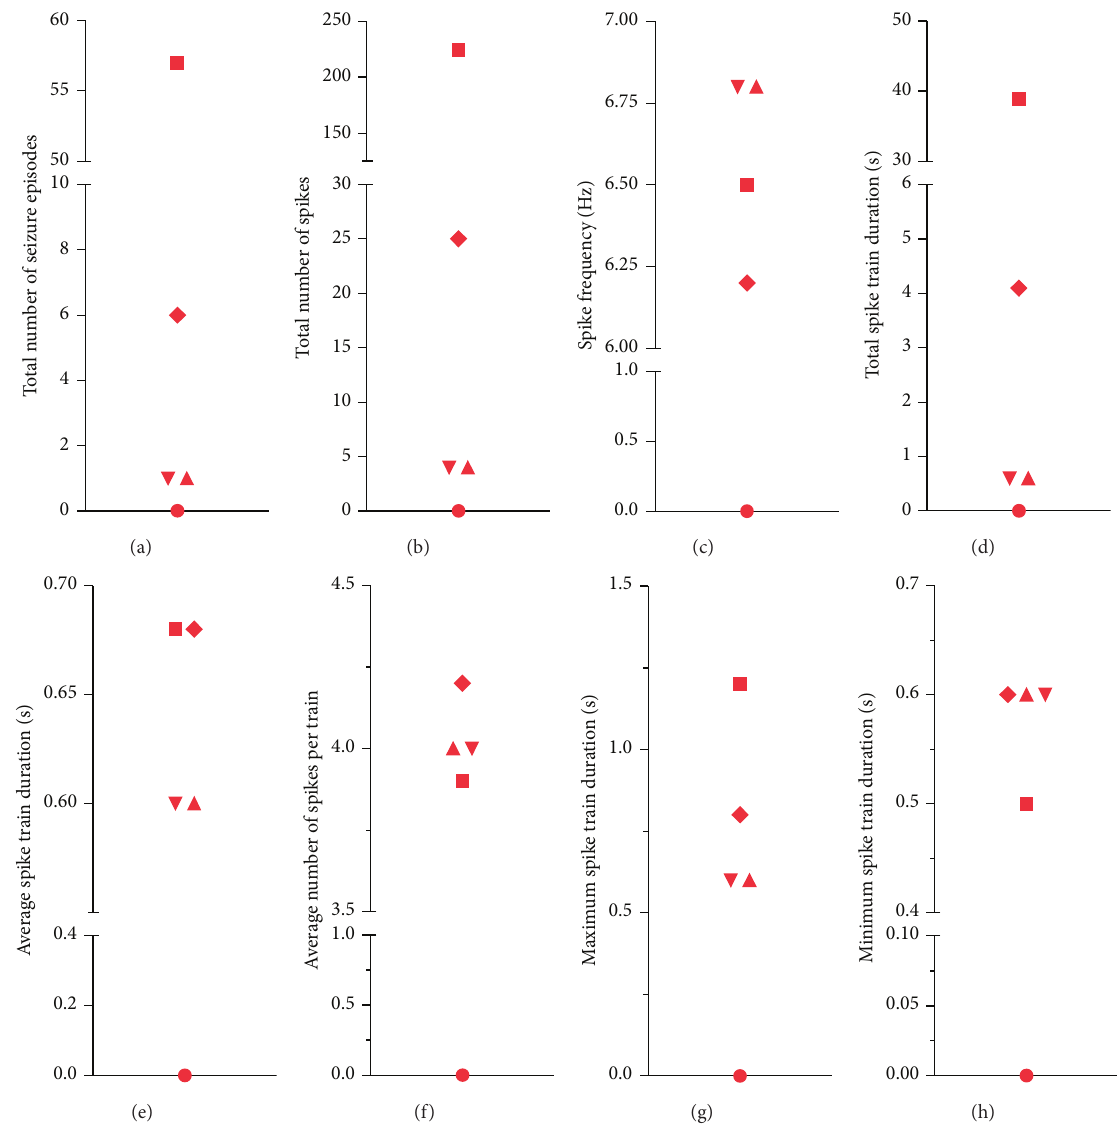
Figure 2: Seizure characteristics in control and 5XFAD mice. Dot plots illustrating results for individual 5XFAD mice. Total number of seizure episodes (a) and spikes (b), spike frequency (c), total (d) and average (e) spike train duration, average number of spikes per train (f), and maximum (g) and minimum spike train duration (h) are depicted. Parameters were analyzed using the NeuroScore Automated Seizure Module (DSI). Note that 5XFAD mice exhibited ictal discharges of highly variable degree whereas none of the controls displayed ictal-like discharges (not